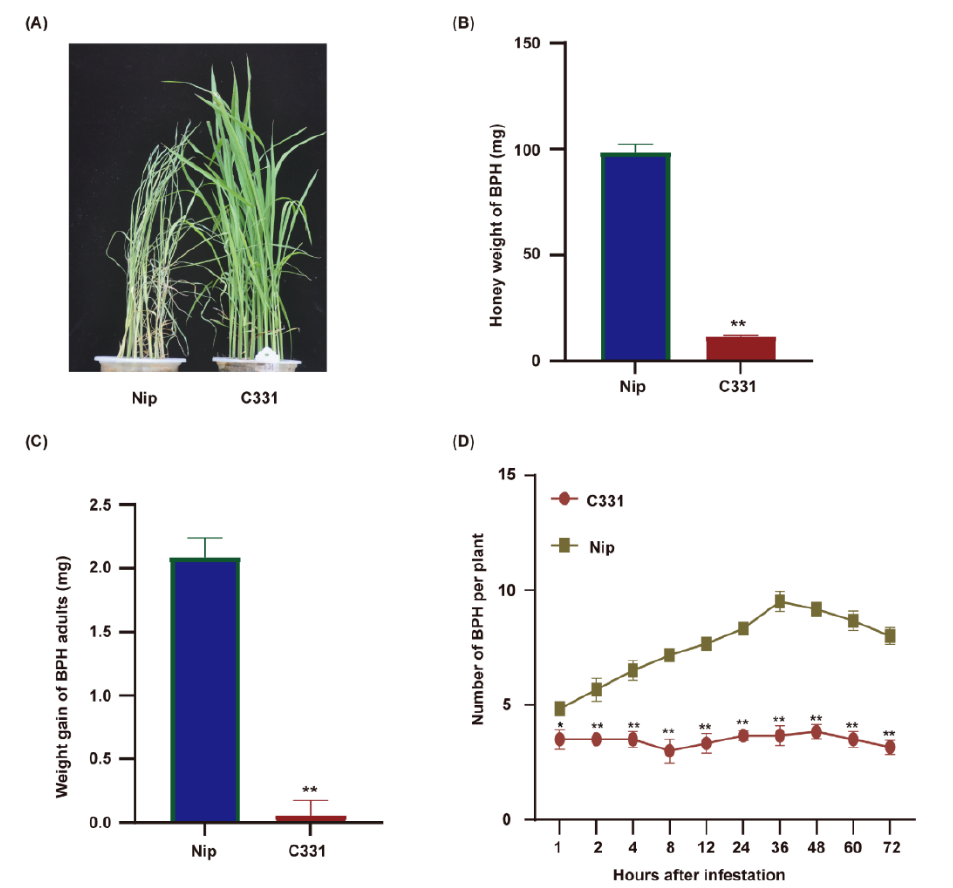
Figure 1. Performance of BPHs on the rice variety Nipponbare and C331. ( A ) BPH-resistance assay of the Nipponbare and C331 rice plants at the seedling stage. 10 BPHs per seeding. ( B ) Honeydew excretion by newly emerged female adult BPHs fed on the Nipponbare and C331 for 48 h. ( C ) Weight gain of newly emerged female adult BPHs fed on the Nipponbare and C331 for 48 h. ( D ) Results of a two-host choice test for BPH insects on the Nipponbare and C331 rice plants. The experiments were repeated with 20 BPH insects per variety ( B , C ). Fifteen BPH insects were placed on each pair of rice line and 6 replicates were used for analysis ( D ). Error bars, mean ± SE ( B – D ). Asterisks indicate significant differences revealed by Student’s t test, at * p < 0.05 and ** p < 0.01, respectively.